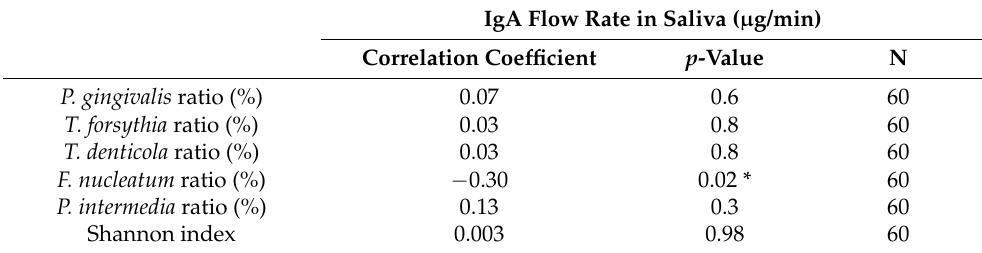
Table 5. Correlation between salivary IgA flow rate and oral bacterial